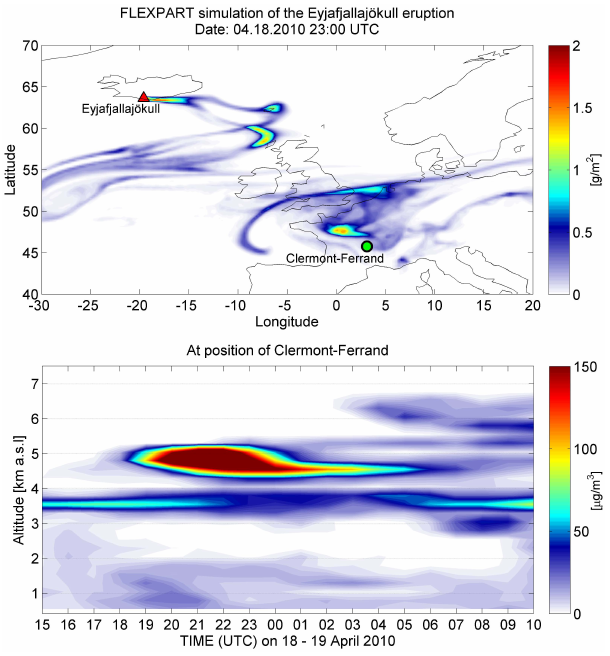
Fig. 8. FLEXPART simulated ash cloud. Total ash column load on 22 April 04:00UTC (upper panel), and simulated vertical distribu- tion of ash over Clermont-Ferrand for 22 April (lower